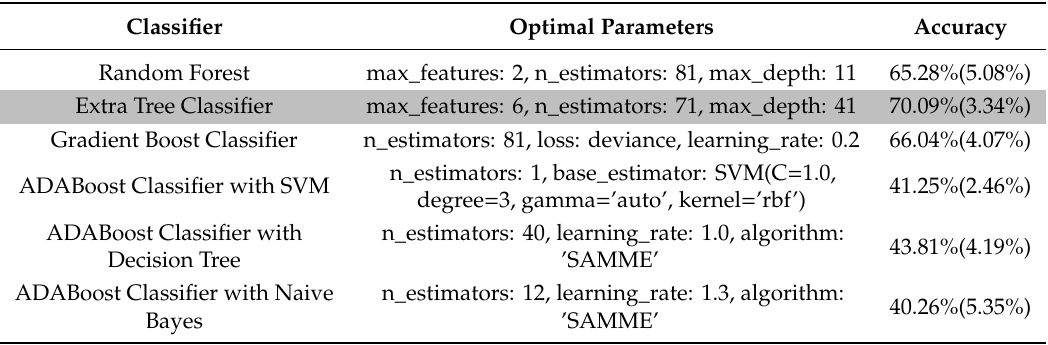
Table 4. Model evaluation